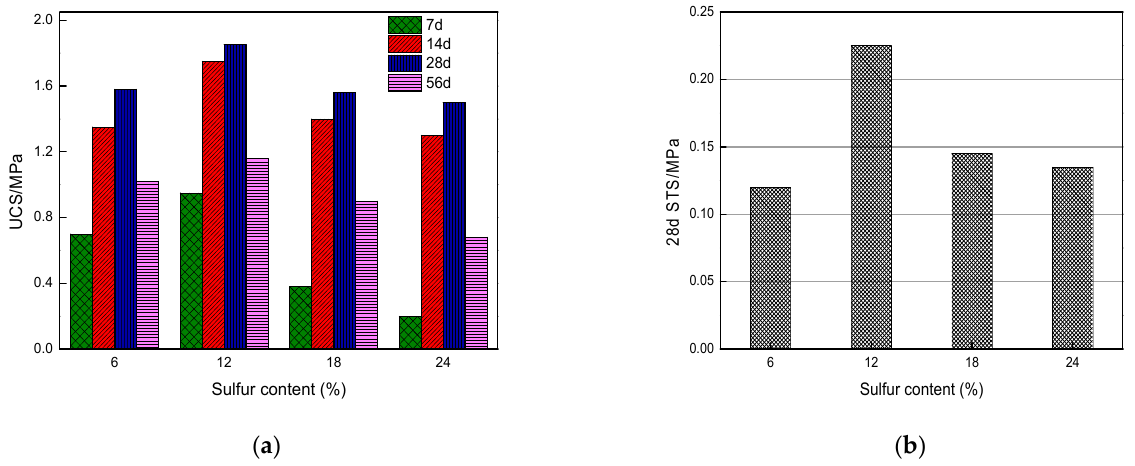
Figure 7. Relationship between sulfur content and UCS and 28 d STS of CSTB samples: ( a ) Uniaxial compressive strength; ( b ) 28 d Splitting tensile strength [34].